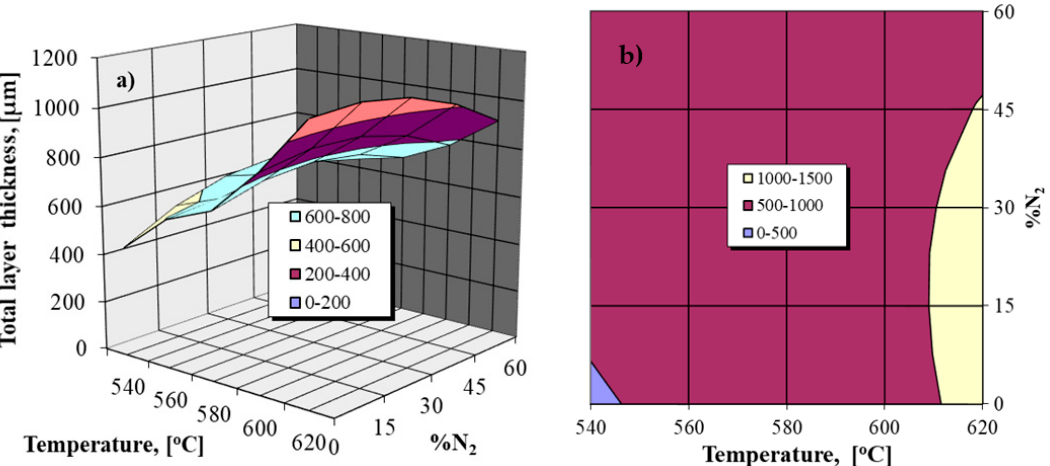
Figure 1. The dependence of the total thickness of the nitrided layer on the nitriding temperature and the nitrogen proportion in the NH 3 + N 2 gaseous mixture for Fe-ARMCO; 4 h holding time; ( a ) the response area of the regression Equation (2); ( b ) iso-properties